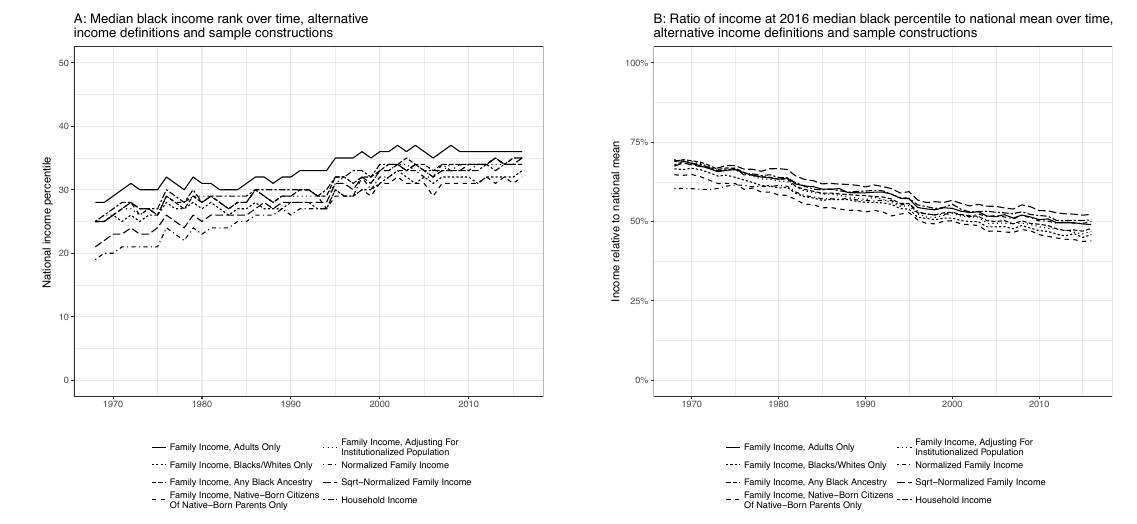
Figure 4: Alternative income definitions and sample